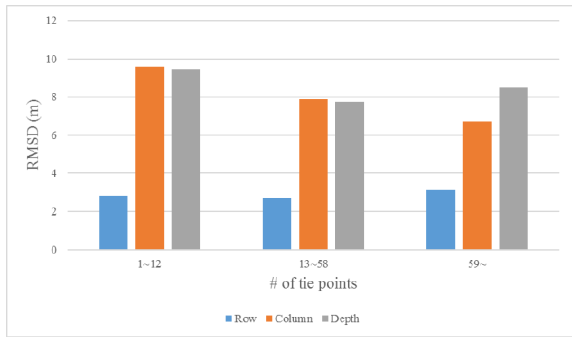
Figure 14. RMSD in case of different number of tie points